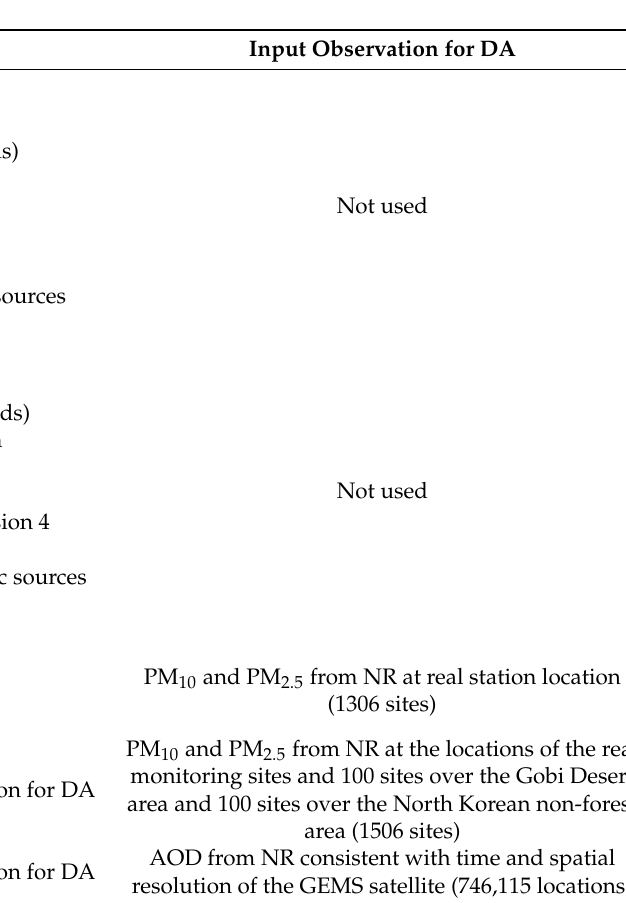
Table 1. The settings for the nature run (NR), control run (CR), and data assimilation run (AR) in the